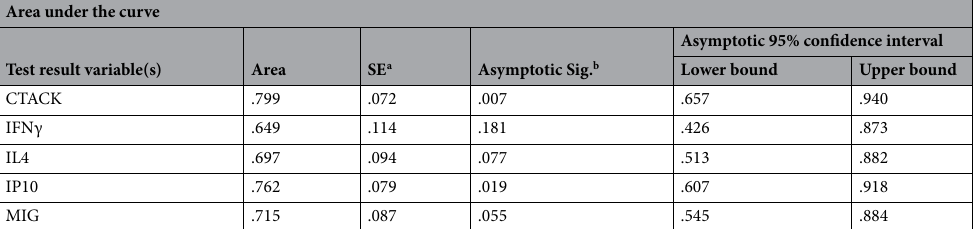
Table 3. Area under the ROC curve of clustering analysis of cytokines diagnosing Meniere’s disease with hypertension. The test result variable(s): CTACK, IFNγ, IL4, TransfMIG has at least one tie between the positive actual state group and the negative actual state group. Statistics may be biased. a Under the nonparametric assumption. b Null hypothesis: true area =